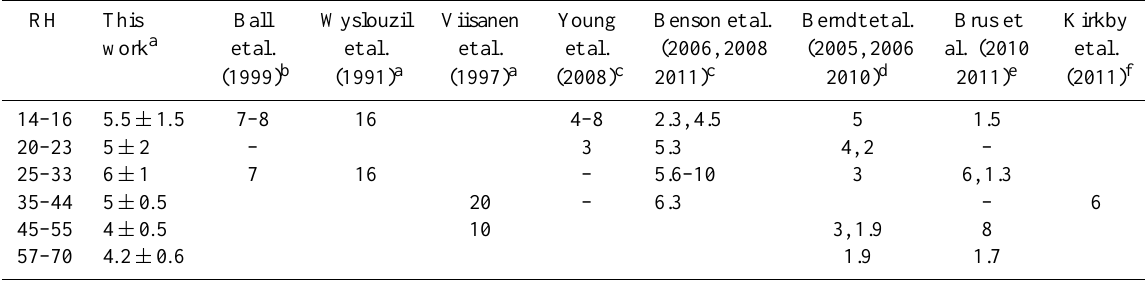
Table 2. Comparison of H 2 SO 4 Power Dependencies at various RH.